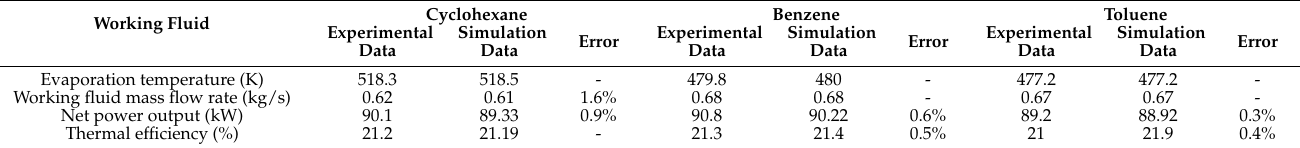
Table 9. Comparison between experimental data and simulation